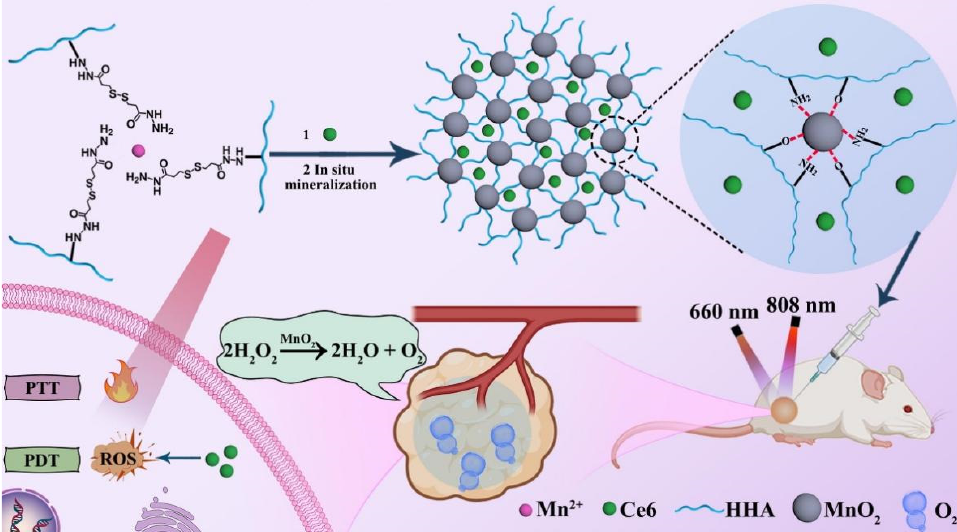
Figure 6. Schematic illustration of HHA-based hydrogel system for synergistic antitumor PTT/PDT. Reprinted with permission from [195].